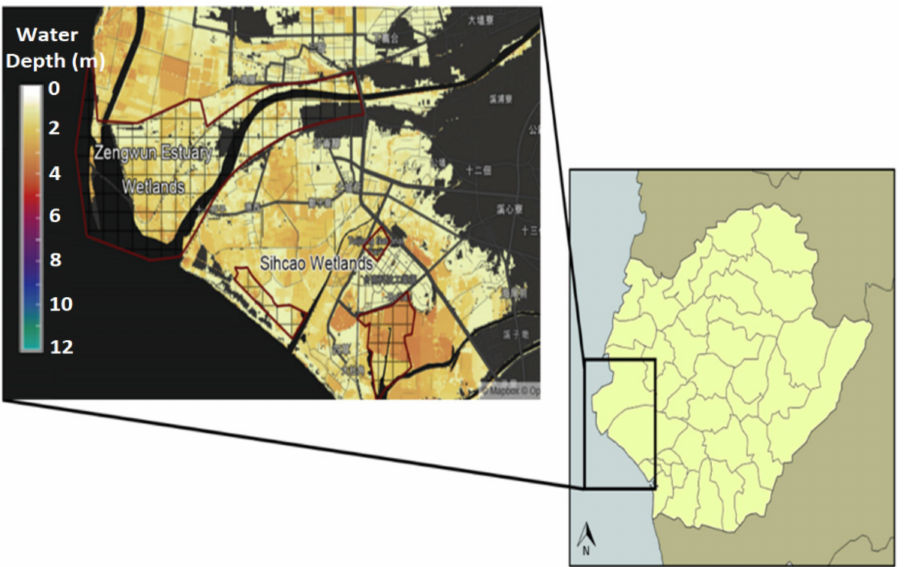
Figure 8. Inundation risk map of wetlands of international